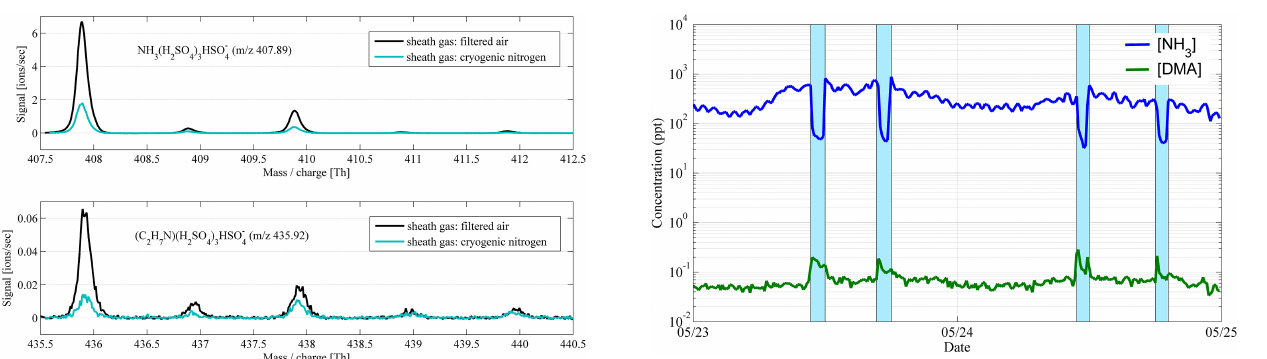
Figure 7. Purity of sheath gas is important for high-sensitivity de- tection. Cryogenic N 2 resulted in 3–5 times lower background than ambient air filtered with particle filter and amine-specific gas mask filter. Still both ammonia and dimethyl amine are visible in the spec- tra, with signals corresponding to several tens of pptV for ammonia and ∼ 100ppqV for dimethyl amine. Data are taken with zero air (N 2 ) fed into the sample inlet.